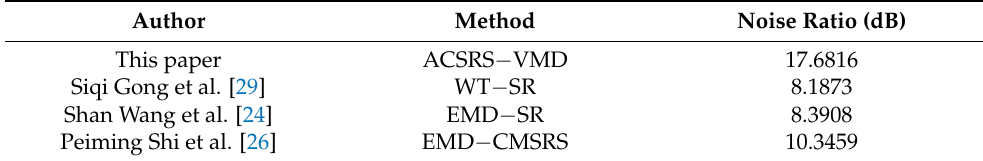
Table 6. Comparison of the signal-to-noise ratio of different